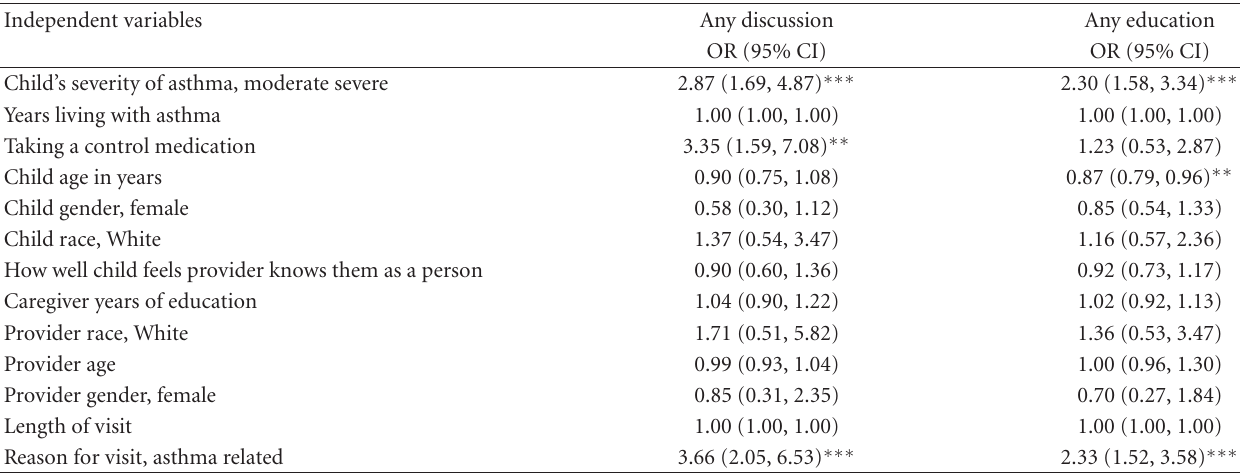
Table 3: Generalized estimating equation results predicting provider discussion of and education about control medications ( N = 296). Independent